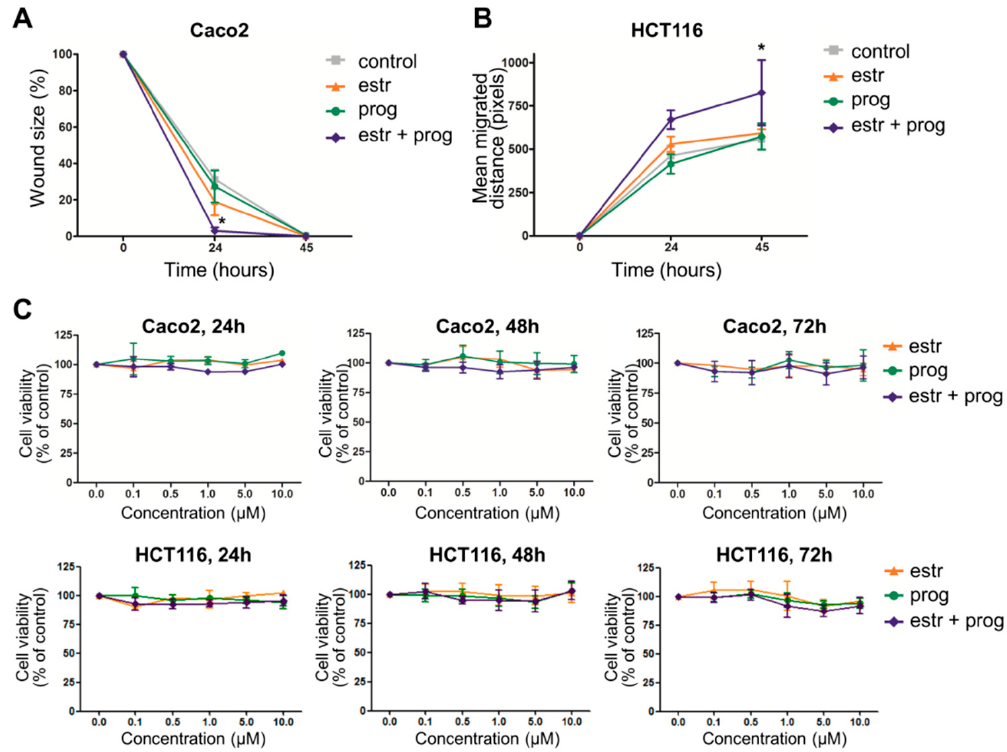
Figure 1. Estrogen and progesterone improve epithelial barrier healing. Caco2 cells’ ( A ) and HCT116 cells’ ( B ) confluent layers were scratched and cultured in the absence or presence of estrogen and/or progesterone. Cells were photographed at 0, 24 and 45 h. Scratch assay of CACO2 cells is presented as mean percentage wound size. Scratch assay of HCT116 is presented as mean migration of wound edges in pixels. Results of five independent experiments are shown, with a minimum of two scratches per stimulus. ( C ) MTT assay shows that sex hormones do not affect viable cell numbers (concentrations of hormone treatment indicated on the X axis). Measurements were done in three independent experiments at t = 24, 48 and 72 h. *statistical significant ( p < 0.05)